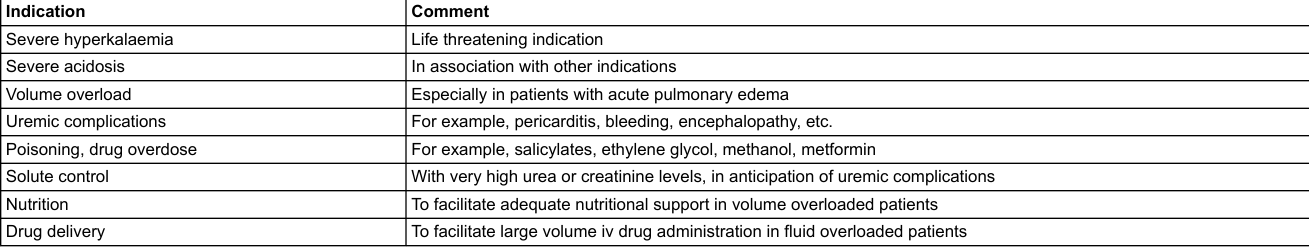
Table S1: Criteria for initiating acute renal replacement therapy with the current KDIGO recommendations.